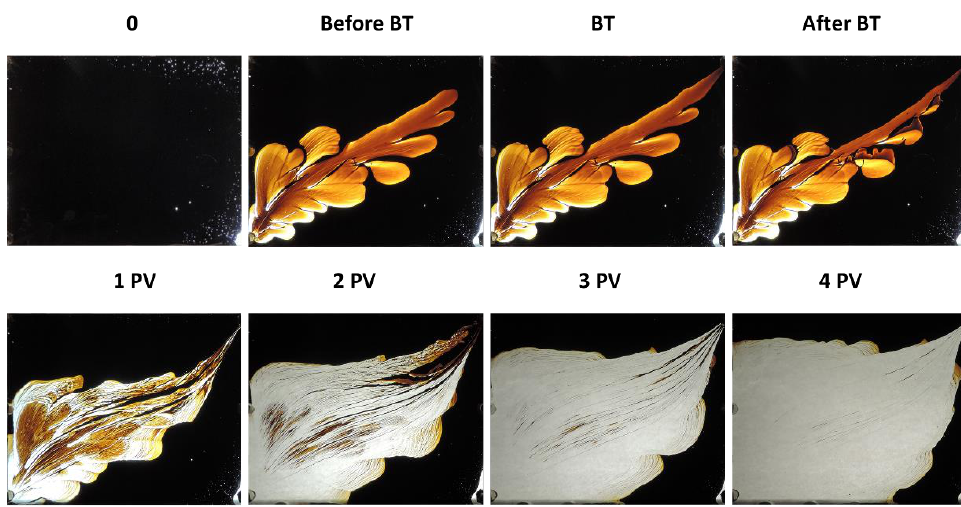
Figure 12. Crude oil displacement by SP flooding at 0.3 mL/min.